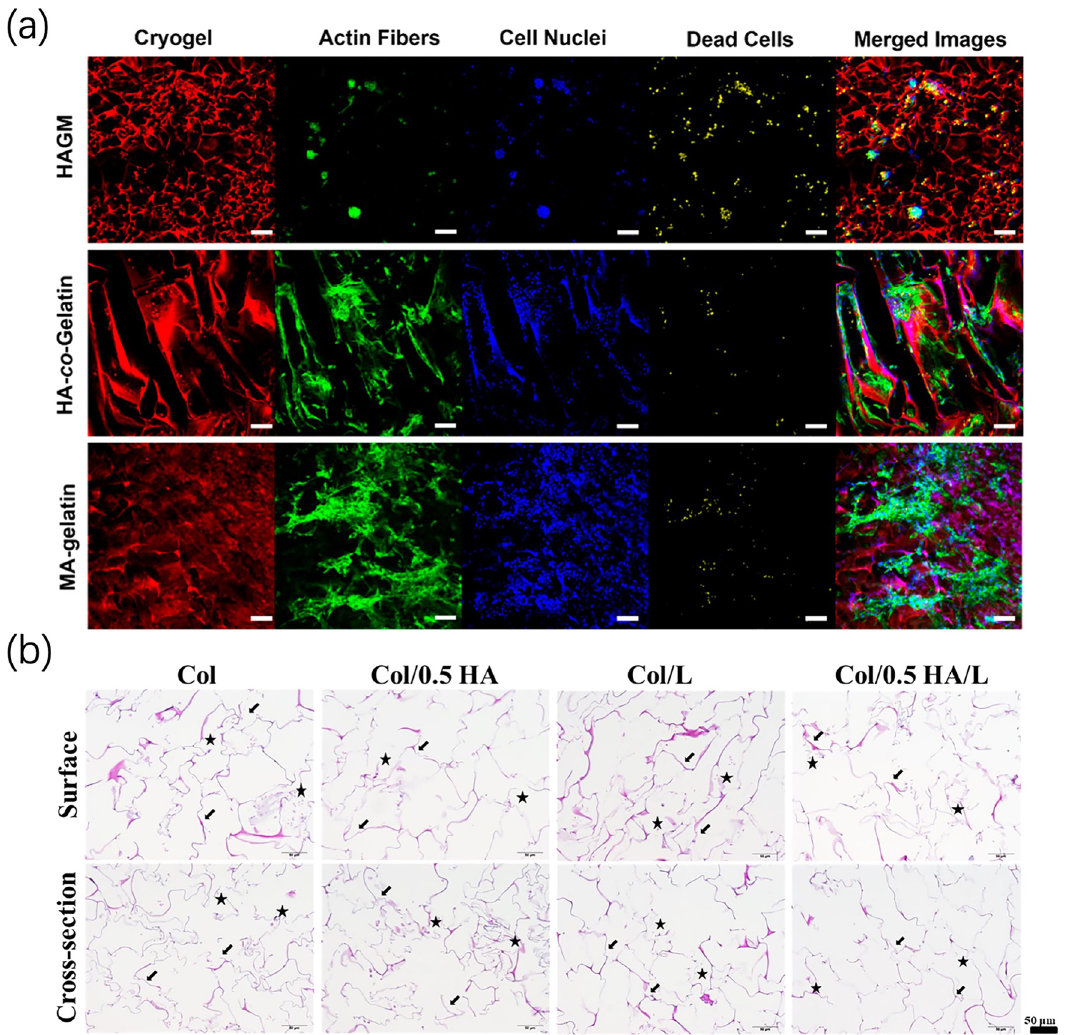
Figure 9: ( a ) Cell viability of hybrid hydrogel [ 127 ] ; ( b ) hematoxylin and eosin stain of coculture of human adipose - derived stem cells and human umbilical vein ECs for 28 days in hybrid hydrogels ( ★ : cells, ↙ : sca ff olds ) [ 130 ]